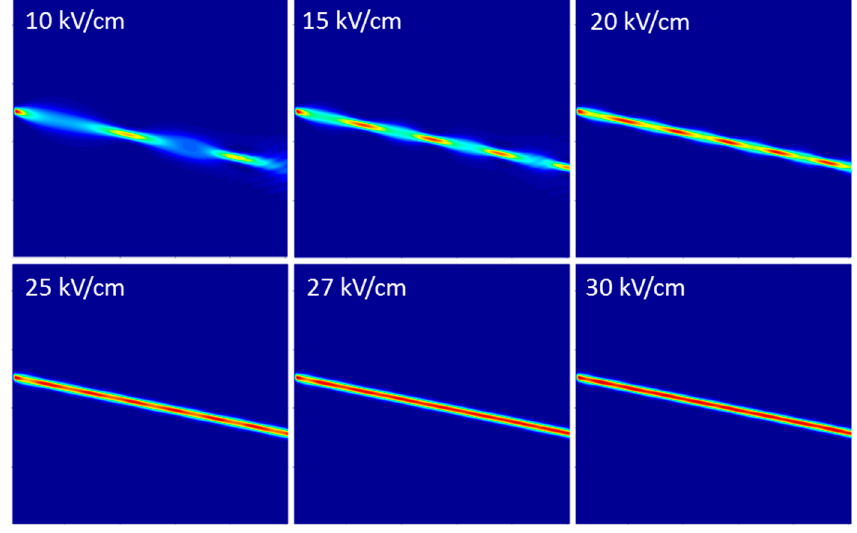
Figure 3. Reflection and refraction dynamics of a soliton beam at an ideal electric interface. The dotted line identifies the position of the electric wall. The applied biases at the two volumes before and after the wall are reported in each case.